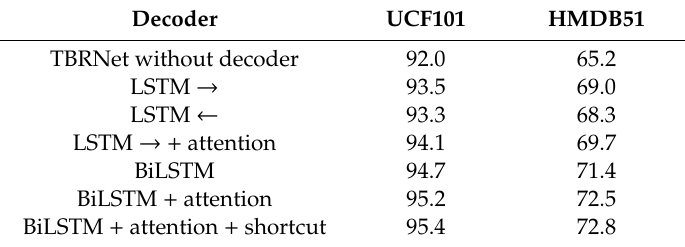
Table 4. The accuracies (%) in ablation study of the attention-based BiLSTM decoder on UCF101 and HMDB51. Here, → denotes the chronological order, and ← denotes the reverse chronological